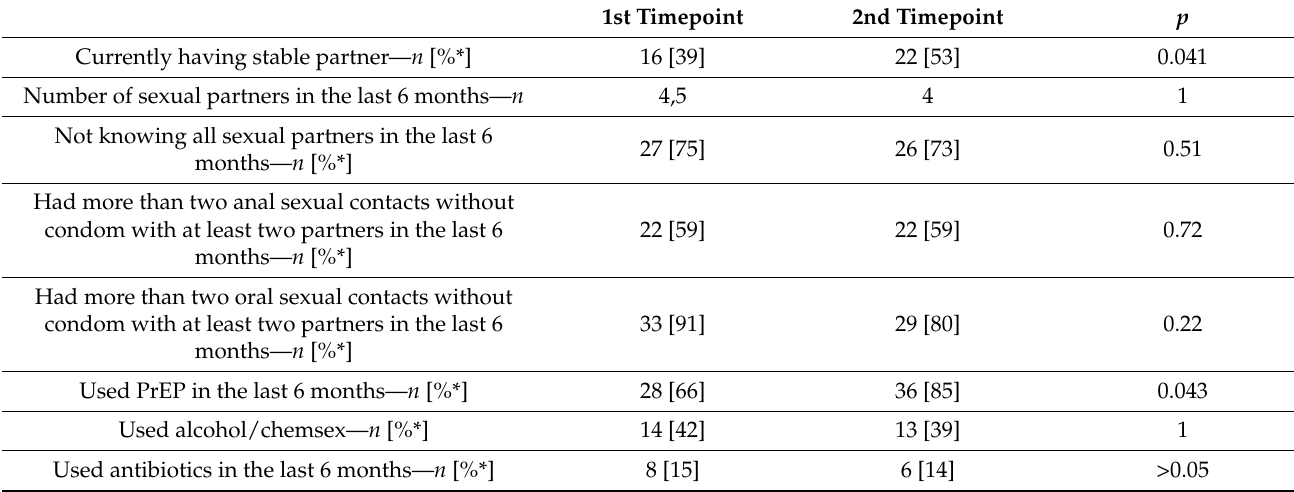
Table 2. Risk change during